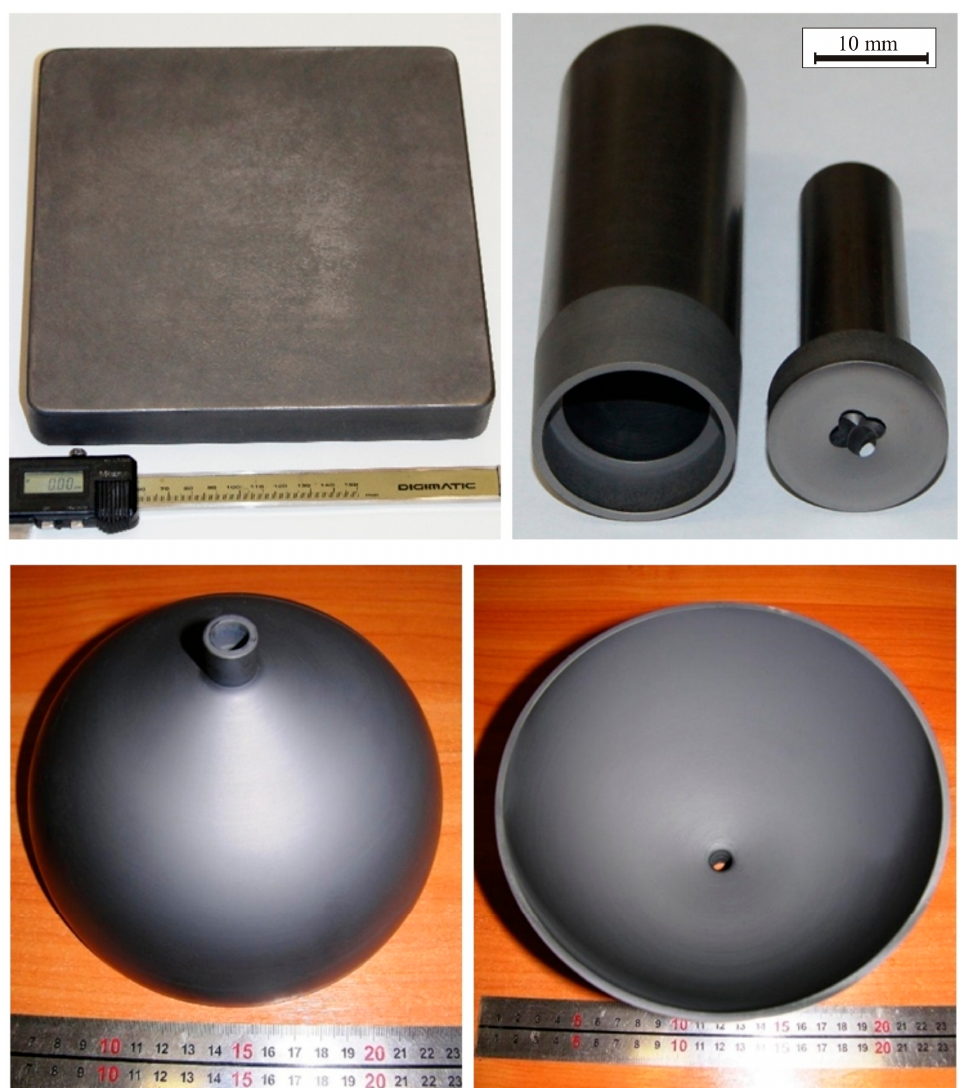
Figure 7. Examples of gas-tight SiC coatings of uniform thickness on the large graphite parts with complicated geometries.